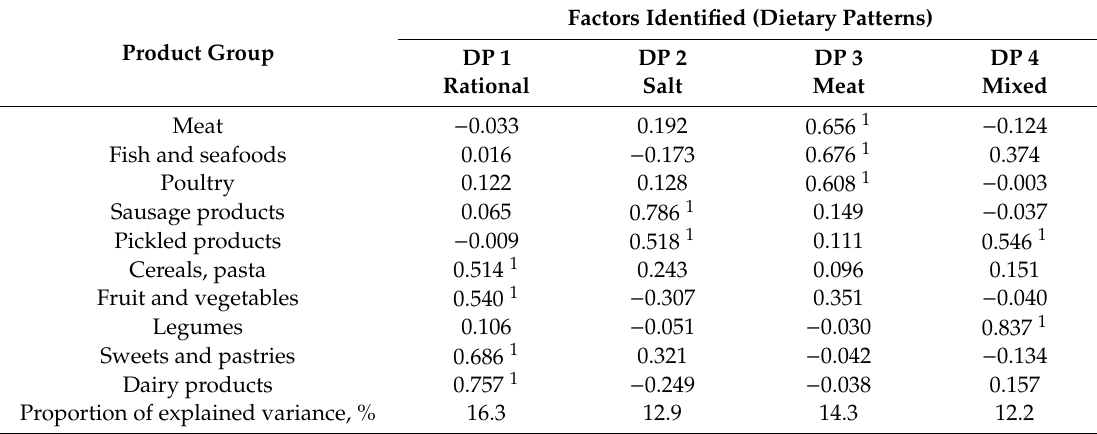
Table A6. Factor loadings of the principal dietary patterns identified (55–64 years).